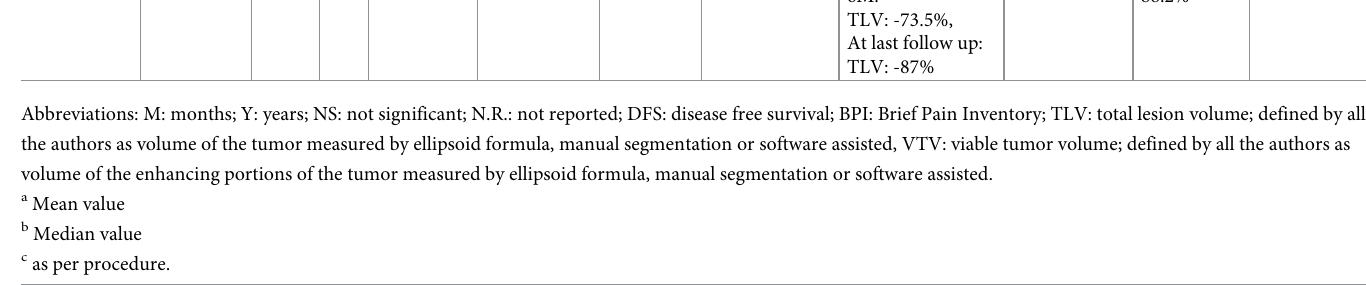
ultrasound-guided open surgery approach instead of percutaneous approach for at risk patients [25]. Shmitz et al. also employed staged cryoablation to minimise the risk of neural injury [22].